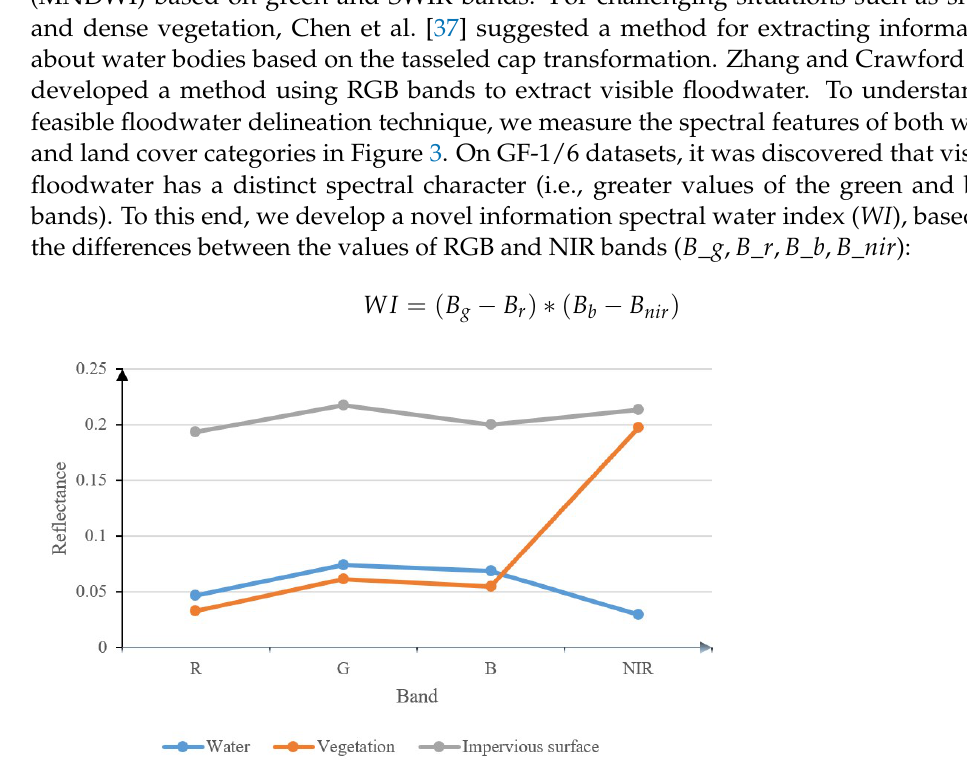
Figure 3. Spectral reflectance of Water, vegetation and impervious surface area in the study area of Dongting